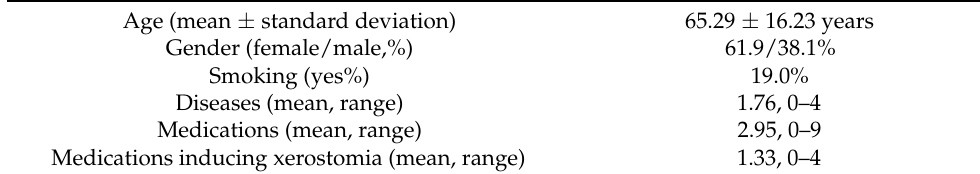
Table 2. Patient